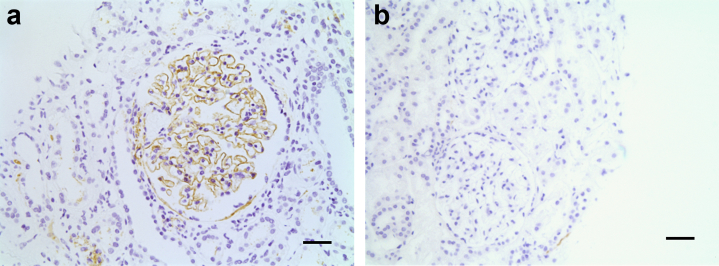
Glomerular immunostaining for complement C5b-9 in control biopsies. Representative images of C5b-9 staining in (a) membranous nephropathy and (b) a renal biopsy reported as within normal parameters. Grade 3 capillary wall staining is seen in membranous nephropathy. No staining is evident in the normal biopsy. Original magnification ×20. Bar = 50 μm. To optimize viewing of this image, please see the online version of this article at www.kidney-international.org.